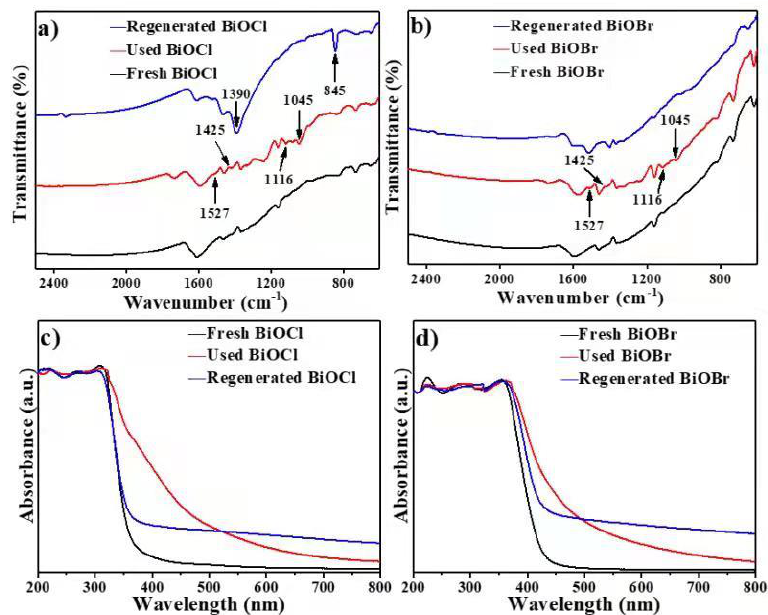
Figure 7. FT-IR spectrum of BiOCl ( a ) and BiOBr ( b ); UV-vis absorption spectra of BiOCl ( c ) and BiOBr ( d ).